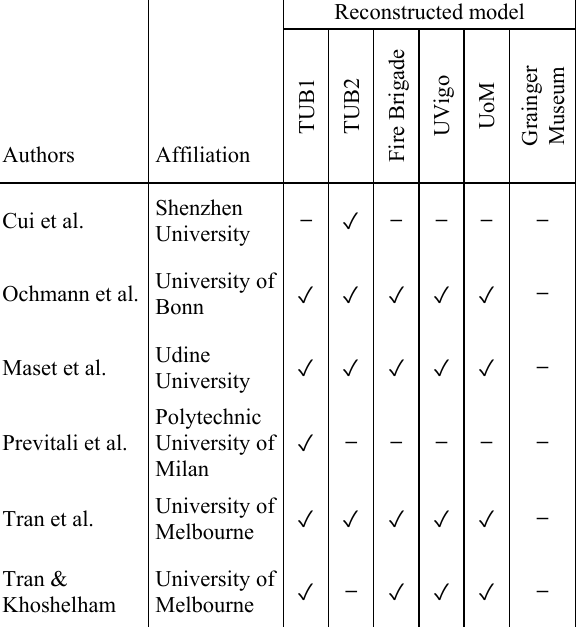
Table 2. Summary of the submissions included in the current